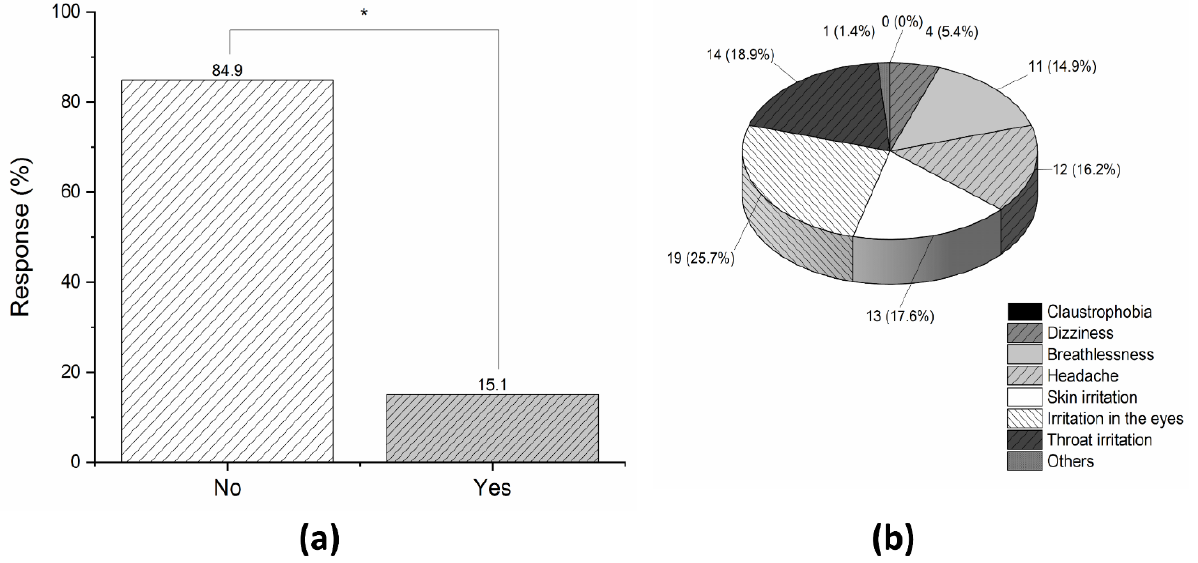
Figure 6. Responses of professionals to the following survey questions: ( a ) Did you experience any discomfort when using the disinfection chamber? ( b ) If yes, please indicate the type of discomfort(s) you felt. * represents p < 0.05 by Friedman test with Dunn’s multiple comparisons test.